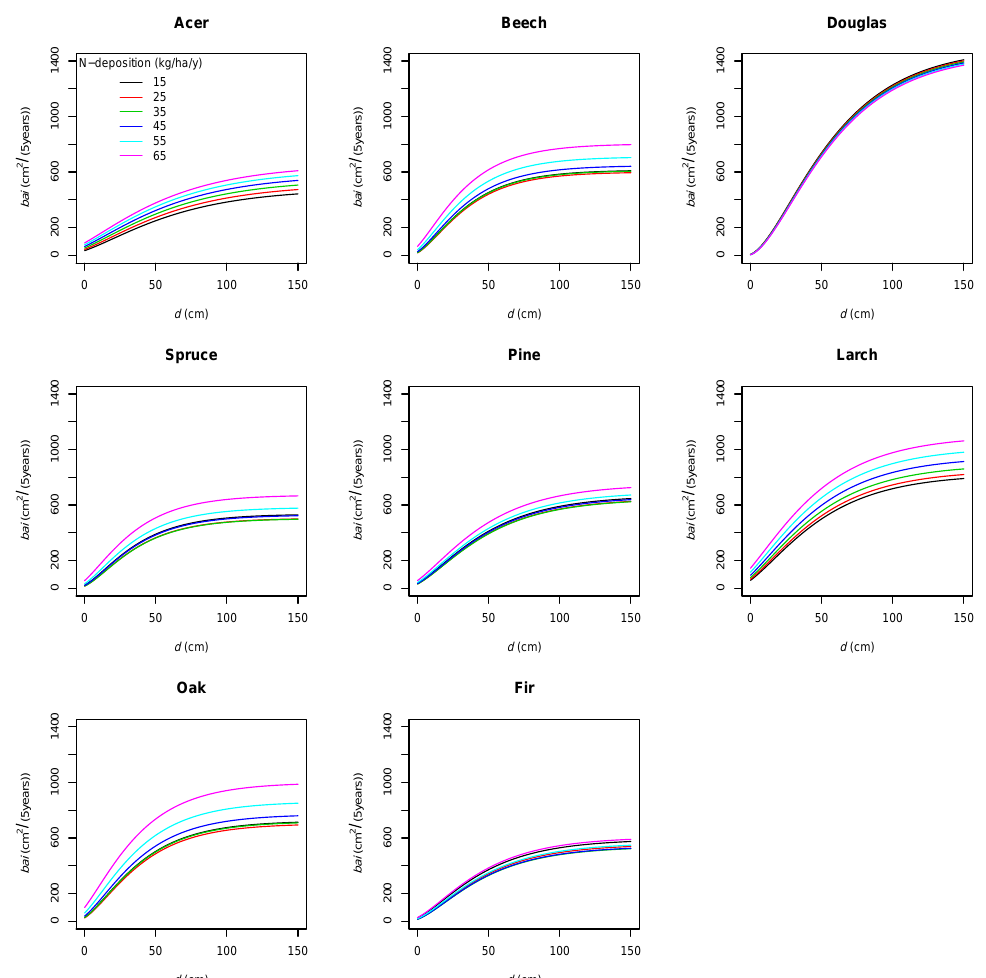
Figure 6. Effects of nitrogen deposition on basal area increment, per tree species. Only diameter and nitrogen deposition effects are shown, all other explanatory variables are held constant